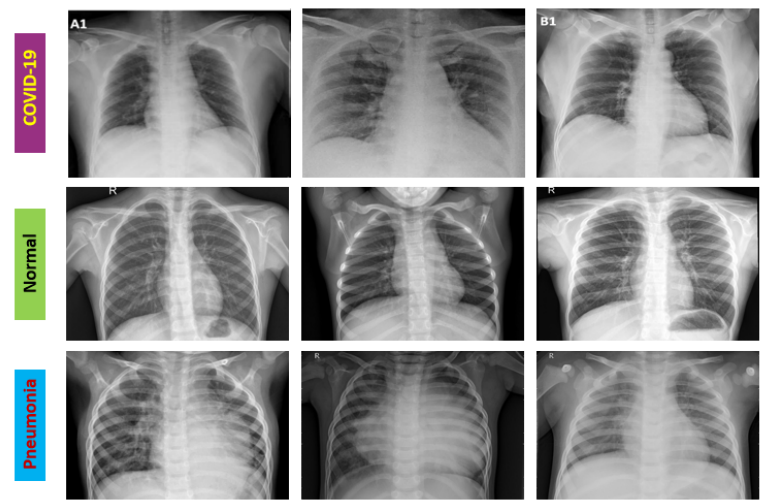
Figure 3. CXR examples for various classes from the test